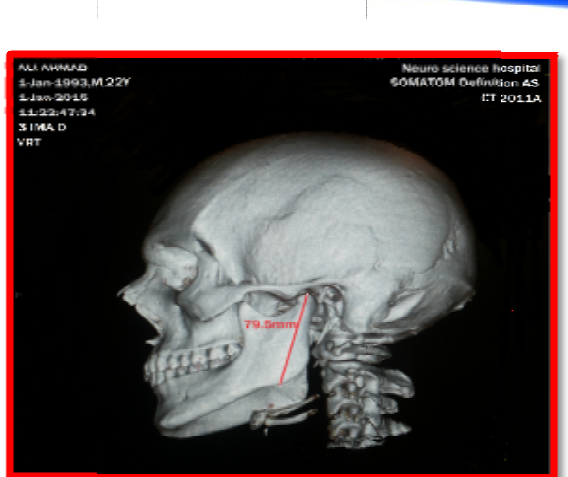
Figure3:Linear measurements of condylar